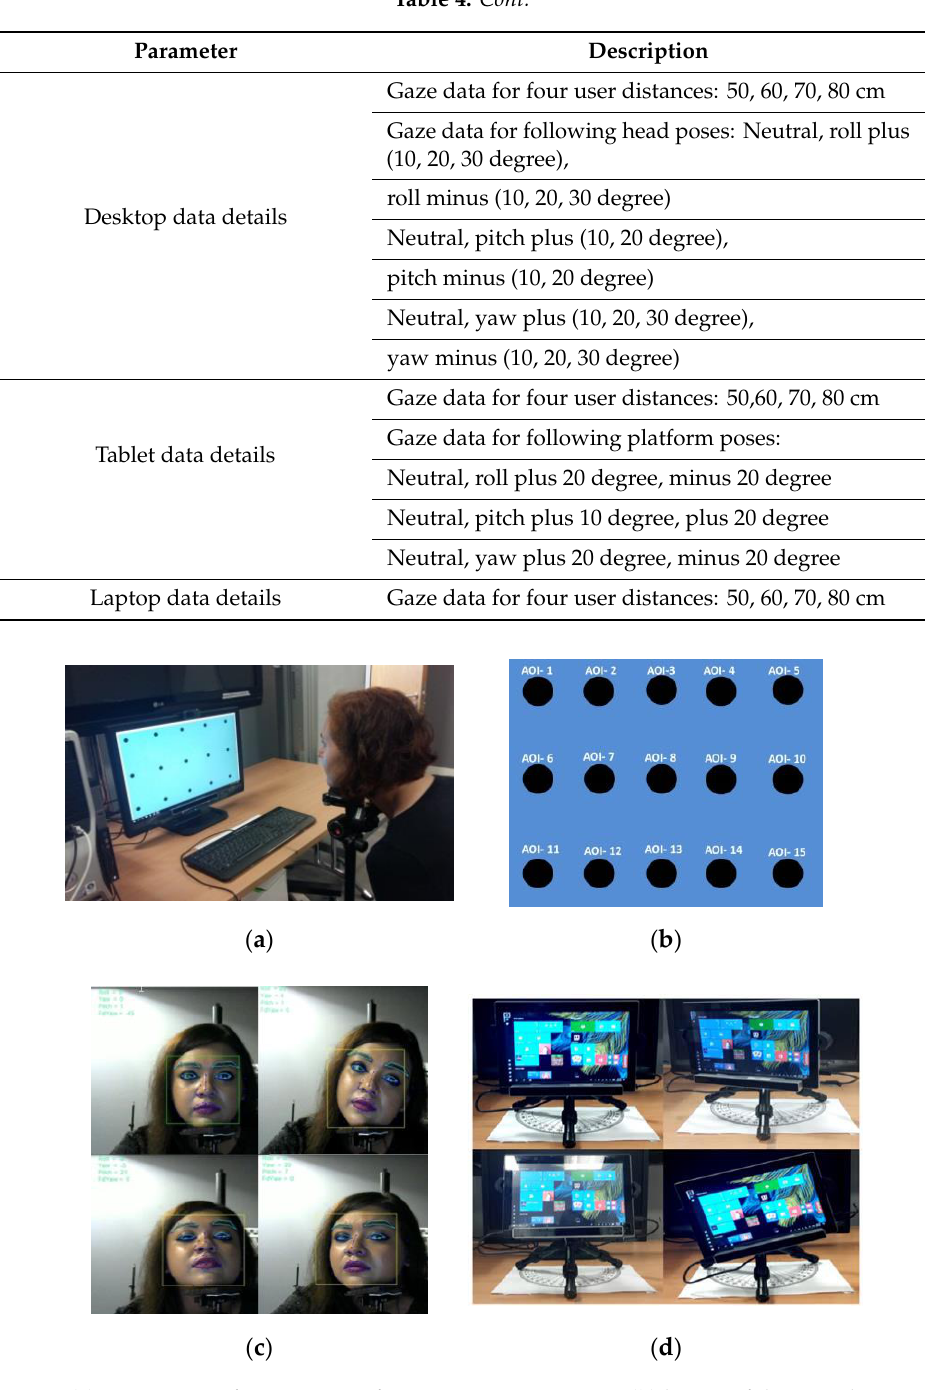
Figure 10. ( a ) Positioning of a participant for an experiment session ( b ) layout of the stimuli points for data collection. AOI stands for area of interest. Different ( c ) head poses and ( d ) tablet poses under which gaze data was collected. Table 4. Features of the gaze data collection process for building the NUIG_EyeGaze01 dataset